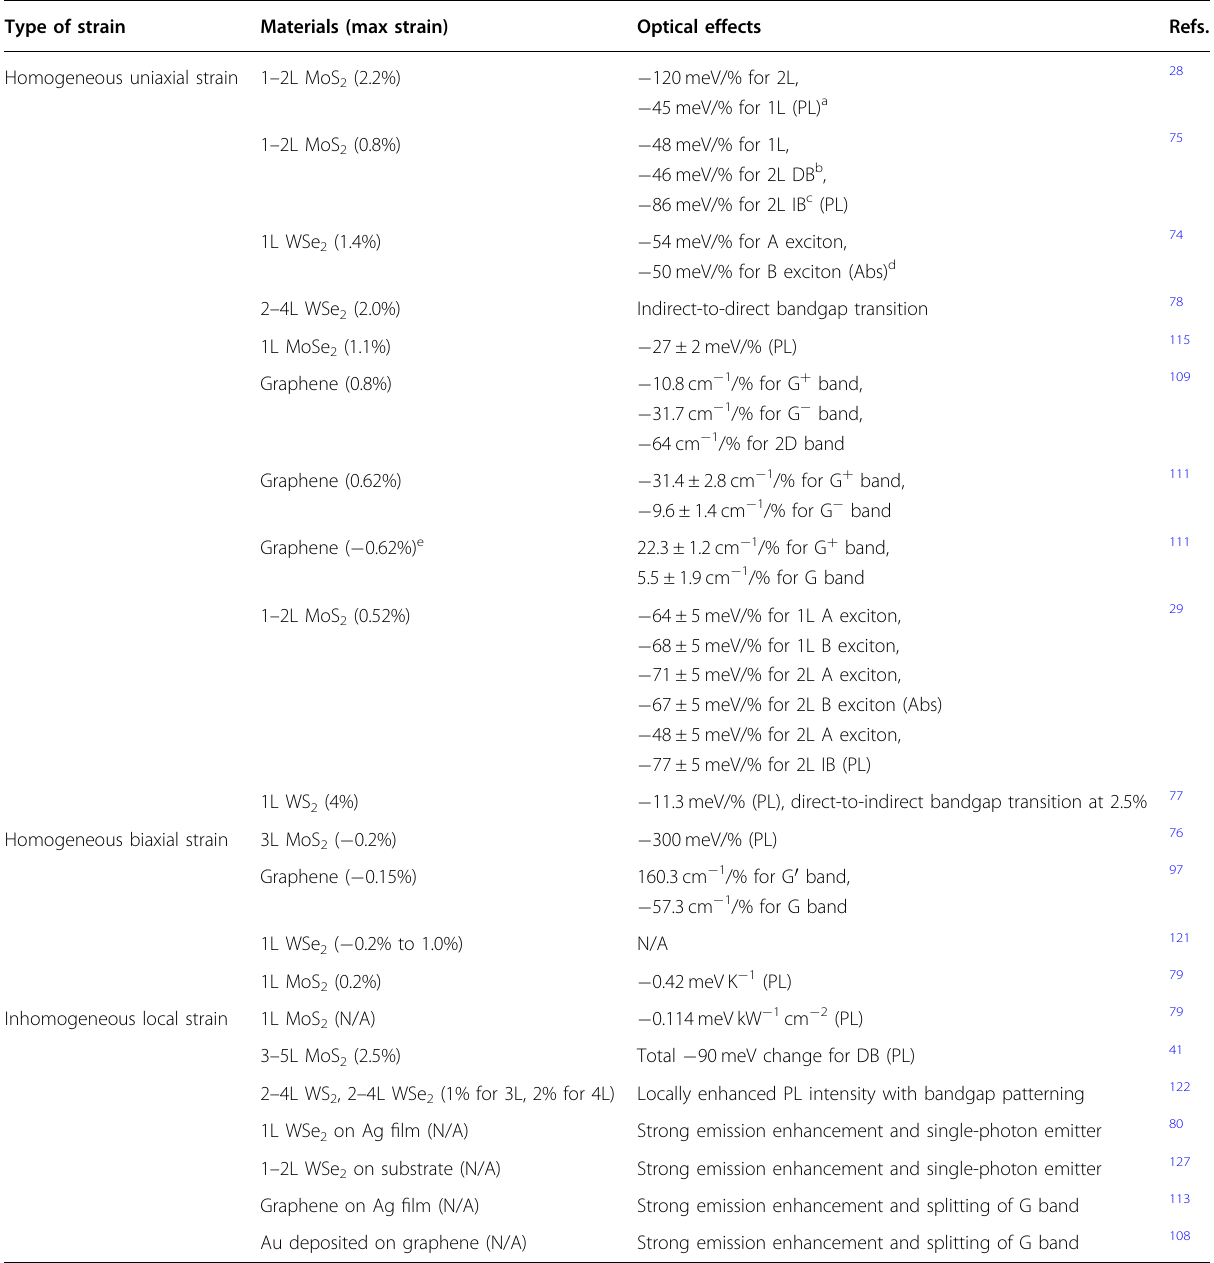
Table 1 Summary of different strains and corresponding optical effects. Type of